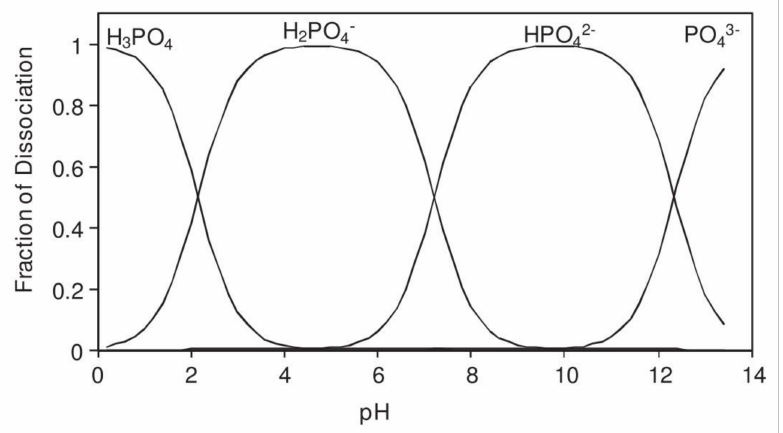
Figure 25. Distribution diagram for phosphoric acid (H 3 PO 4 ) [43]. Reproduced with permission from Bastidas, D.M. et al., Cem. Conc. Comp.; published by Elsevier,